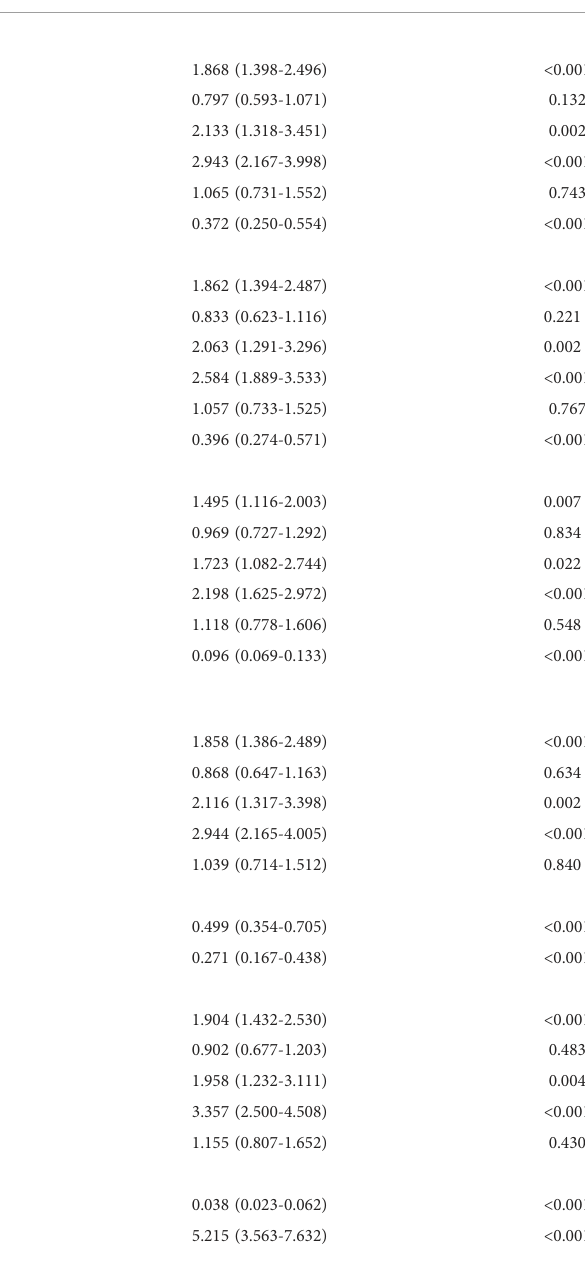
TABLE 3 Multivariate Cox regression analysis of Lnc RNA 604, miRNA564, ZNF326, Lnc RNA 604/miRNA564, Lnc RNA 604/ZNF 326 expression and clinicopathological variables predicting survival in patients with CRC.